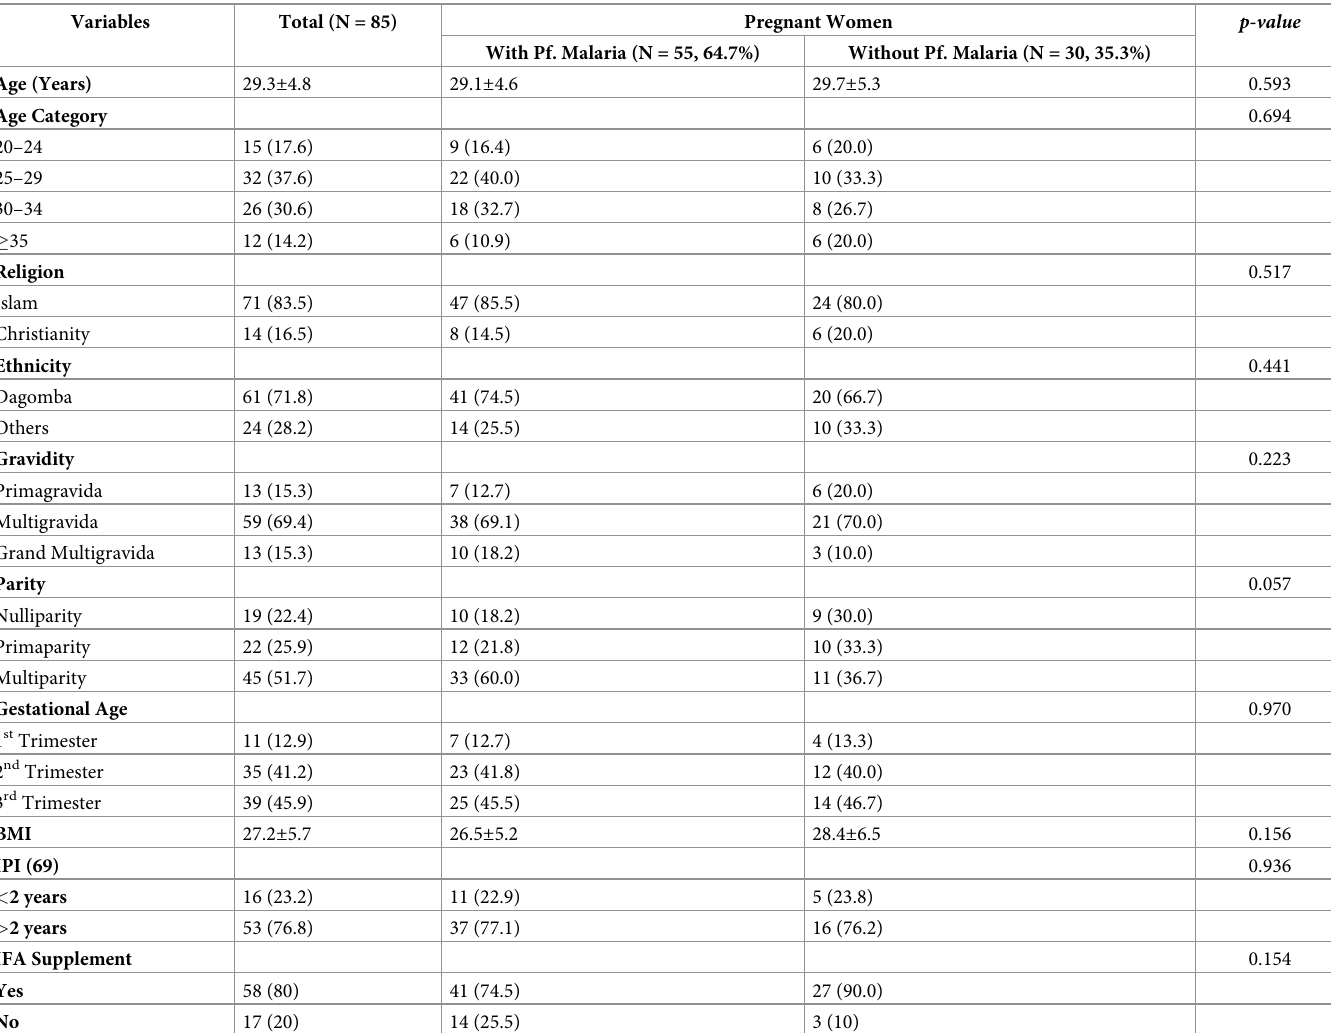
Table 1. Demographic and clinical characteristics of the study